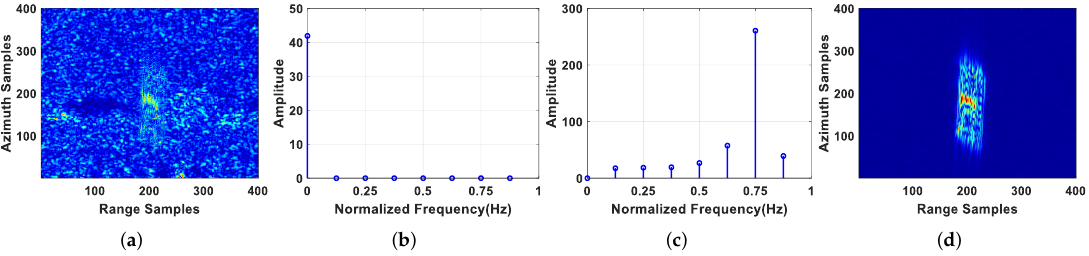
Figure 11. Imaging result of T6 via BP algorithm: ( a ) subimage of T6 before clutter suppression; ( b ) velocity spectrum of a static target in the subimage; ( c ) velocity spectrum of T6; ( d ) subimage of T6 after clutter suppression.